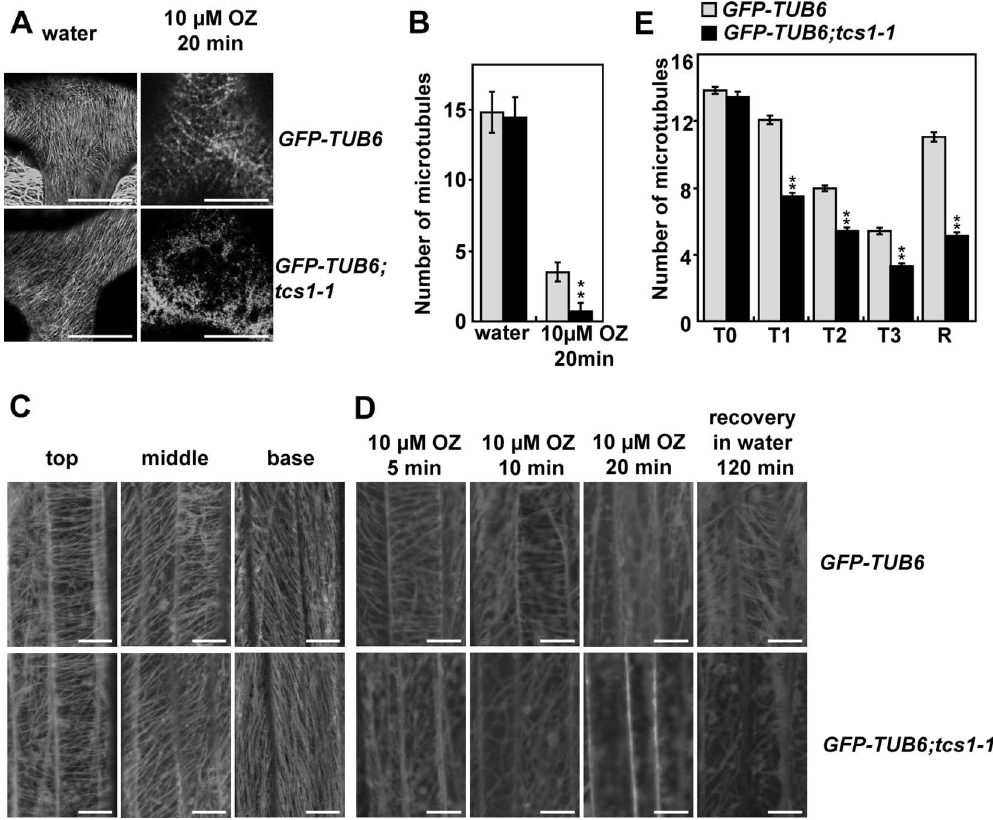
Fig 3. Disruption of TCS1 influences the stability of microtubules in trichomes. (A) Cortical microtubules in trichome cells of GFP-TUB6 and GFP-TUB6;tcs1-1 treated with water or 10 μ M oryzalin (OZ) for 20 minutes. Bars = 20 μ m. (B) The microtubule density at the branch junction of GFP-TUB6 and GFP-TUB6;tcs1-1 trichome cells treated with water or 10 μ M oryzalin for 20 minutes. ImageJ software was employedto quantify the numbers of cortical microtubules. A line of fixed length (10 μ m) perpendicular to the orientationof the most cortical microtubules at the trichome branch junction was drawn, and the number of cortical microtubules across the